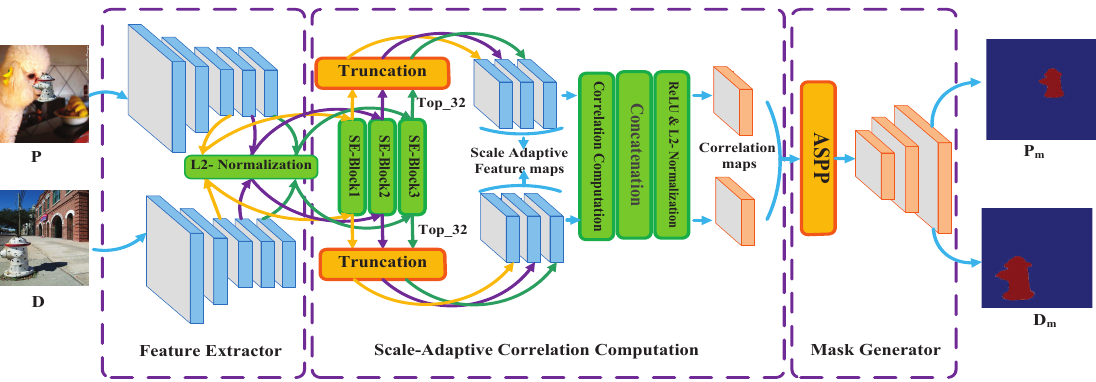
Figure 1. Overview of the proposed SADM. The probe P and potential donor image D are input to the network. Three groups of feature maps with the same size are generated from the feature extractor. They are processed with the scale-adaptive correlation computation module composed of L2-Normalization, SE block, correlation-computation and ReLU. It generates two correlation maps, which are fed into the mask generator with attention-based separable convolutional blocks to generate two fine-grained masks P m and D m